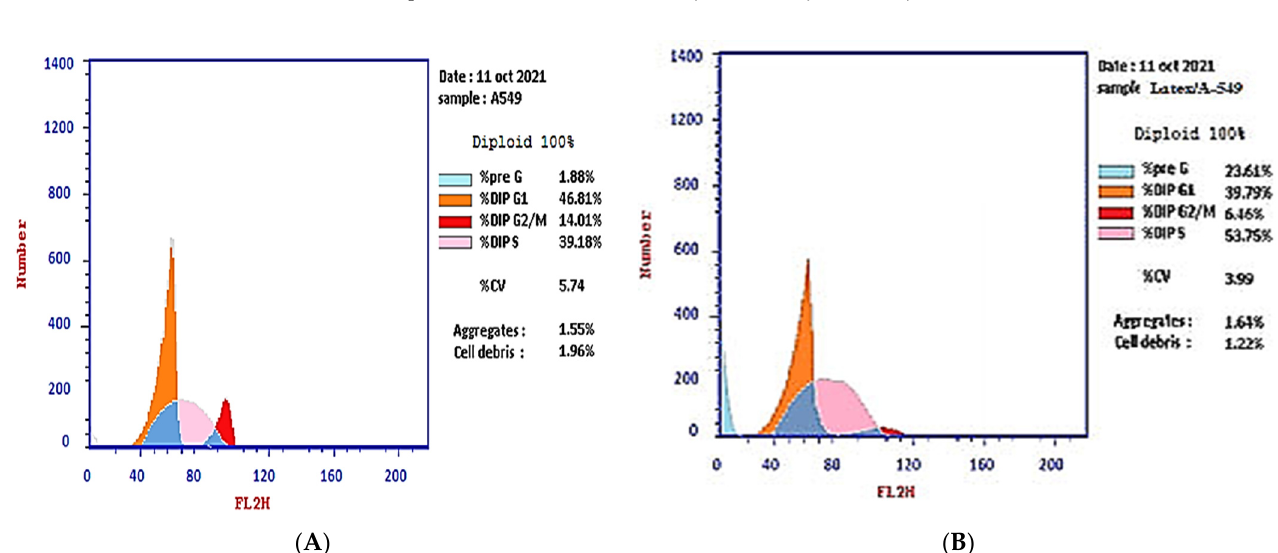
Figure 2. Photograph of the flow cytometry analysis shows the effect of 3.8 µg/mL of the plant latex of P. tomentosa L . compared to the negative control on the phases of the cell cycle of the lung cancer cell line (A-549). ( A ) negative control and ( B ) plant latex of P. tomentosa L.